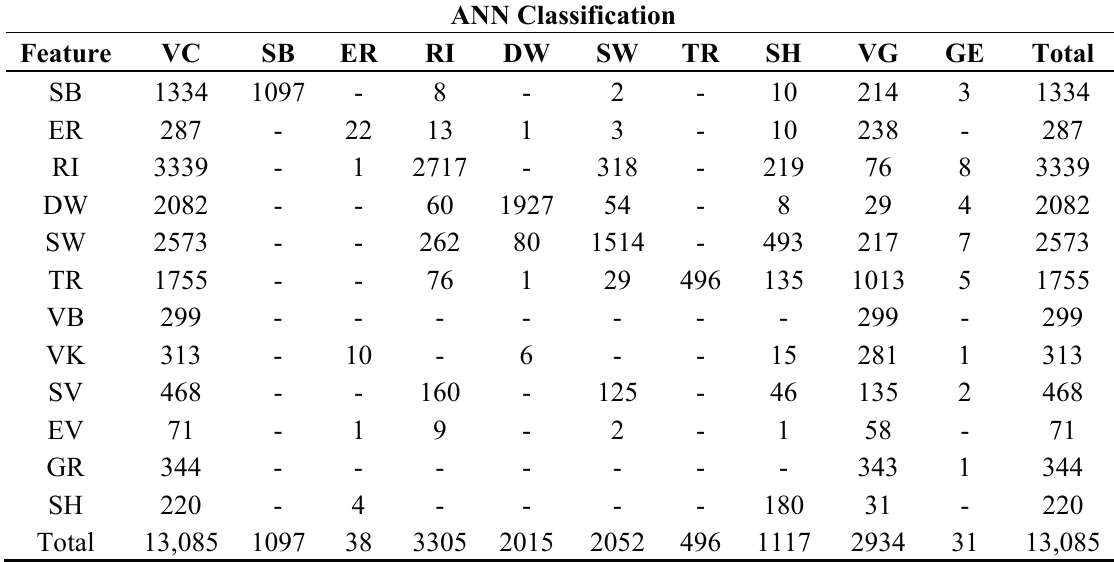
Table 3. Confusion matrix of visual classification (VC) versus Artificial Neural Network (ANN) classification. Feature codes have been abbreviated as follows: side bars (SB), erosion (ER), riffle (RI), deep water (DW), shallow water (SW), tree (TR), shadow (SH), vegetation (VG), vegetated bar (VB), vegetated bank (VK), submerged vegetation (SV), emergent vegetation (EV) and grass (GR). GE stands for georeferencing